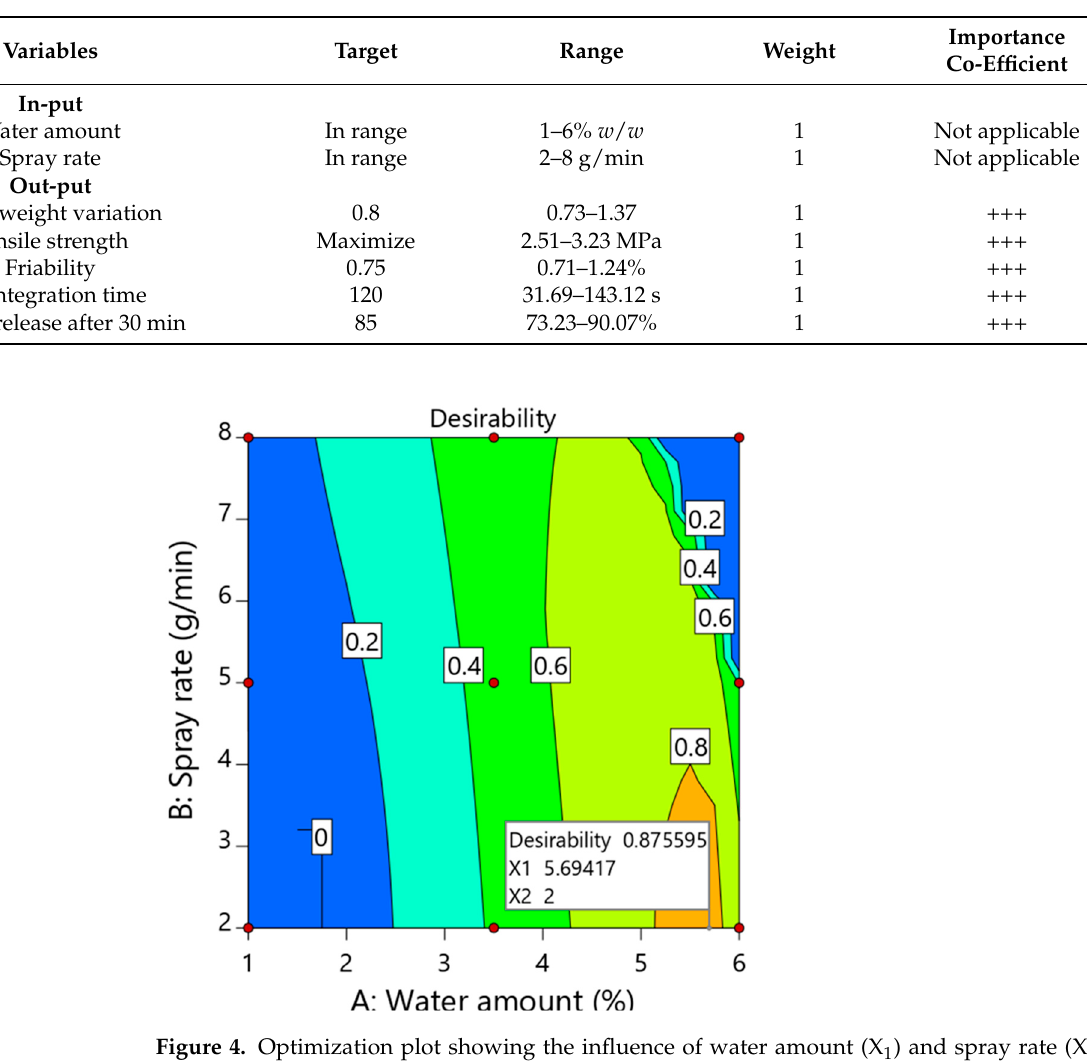
Table 10. The constraints adopted for developed design space.